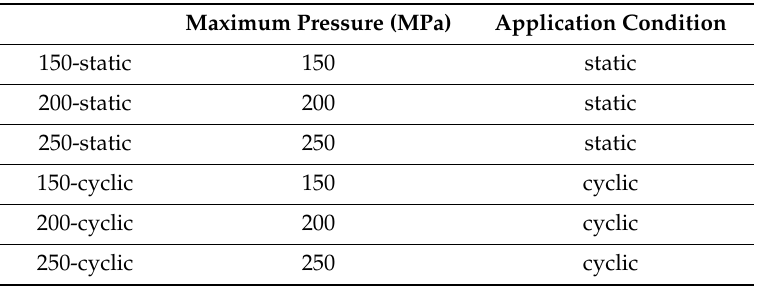
Table 1. HHP application conditions in this study.